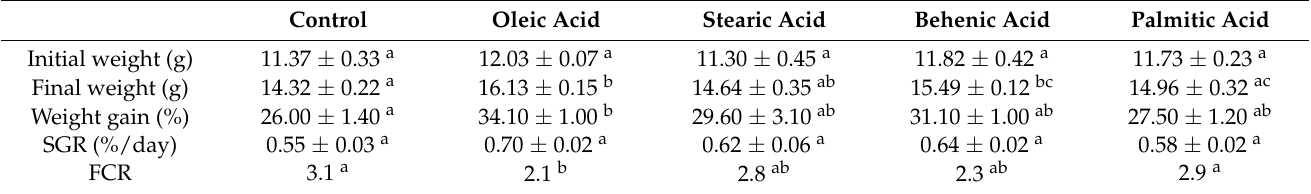
Table 3. Growth performance and feed efficiency of grouper fingerlings at six-week post-feeding with five different dietary fatty